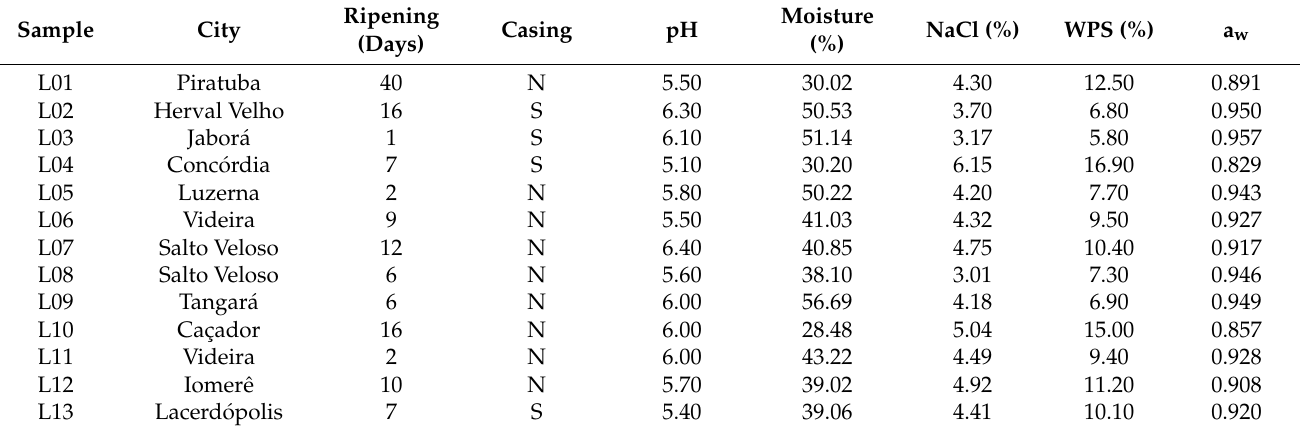
Table 1. Origin of Colonial salami-type dry-fermented sausages in Santa Catarina State, ripening time and physical-chemical characteristics.